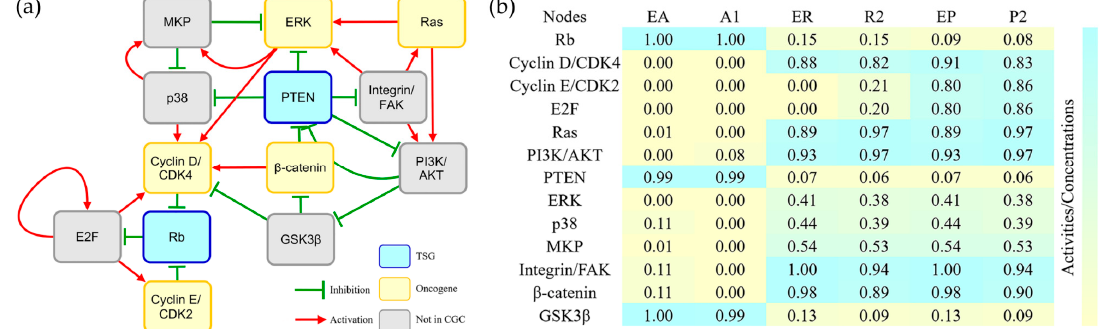
Figure 1. Eukaryotic subnetwork and its attractors ( a ) The network contains 13 nodes and 27 interactions. The colors of nodes indicate different cancer gene types: yellow for oncogene, blue for tumour suppressor genes (TSG), and grey for genes not collected in the Cancer Gene Census (CGC). The red arrows and green T-heads indicate activation and inhibition interactions, respectively; ( b ) The comparison of attractors of eukaryotic endogenous subnetwork and gastric cancer endogenous network. The numbers and color gradation are the normalized relative activities/concentrations that range from 0 (yellow) to 1 (blue) for minimal to maximal activity. A1, R2 and P2 are attractors of the gastric cancer endogenous network [15] that reflect cell cycle arrest, stress response, and proliferation, respectively. EA, ER and EP are attractors of the eukaryotic endogenous subnetwork, which are similar to A1, R2, and P2, respectively.